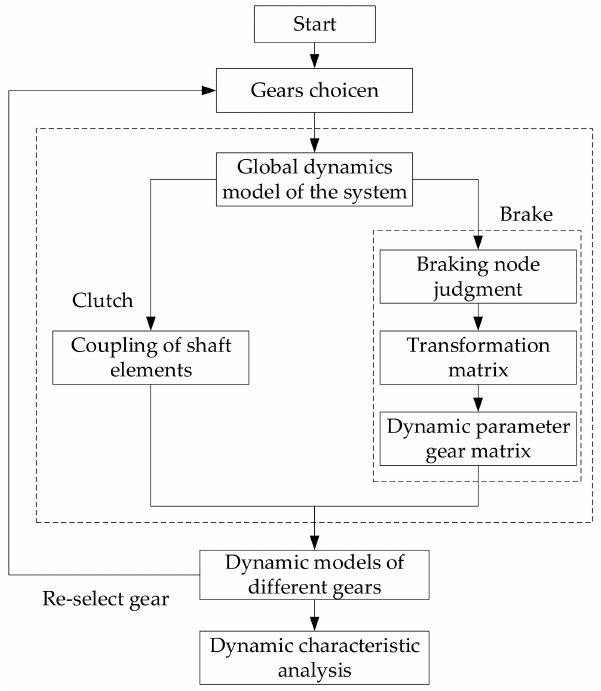
Figure 8. Flow chart of generalized dynamics